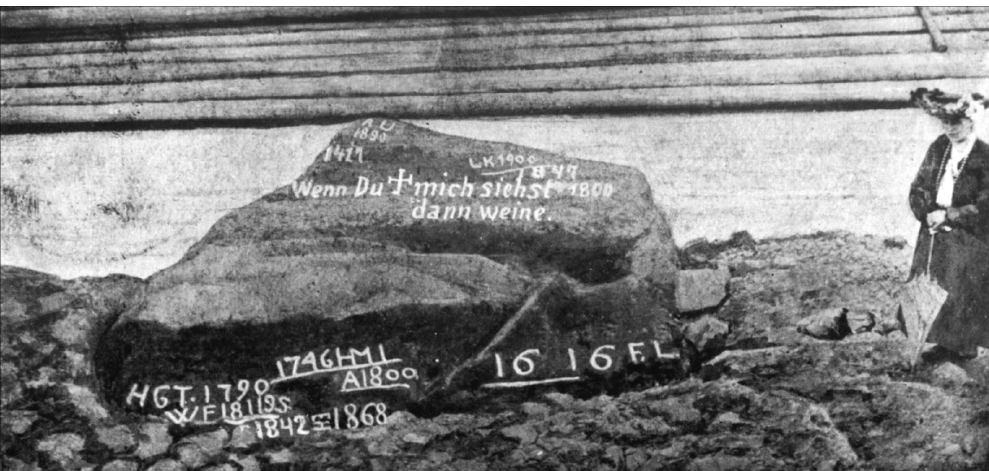
Figure 4. A hunger stone that appeared during the severe 1904 drought, situated on the left bank of the river Elbe at Dˇeˇcín-Podmokly, with records of years and low water levels and a warning inscription (O. Kotyza